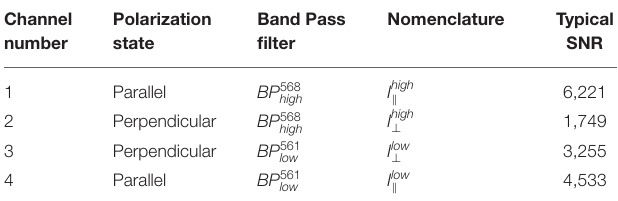
TABLE 1 | Nomenclature adopted for each spectral channel and typical SNRs.